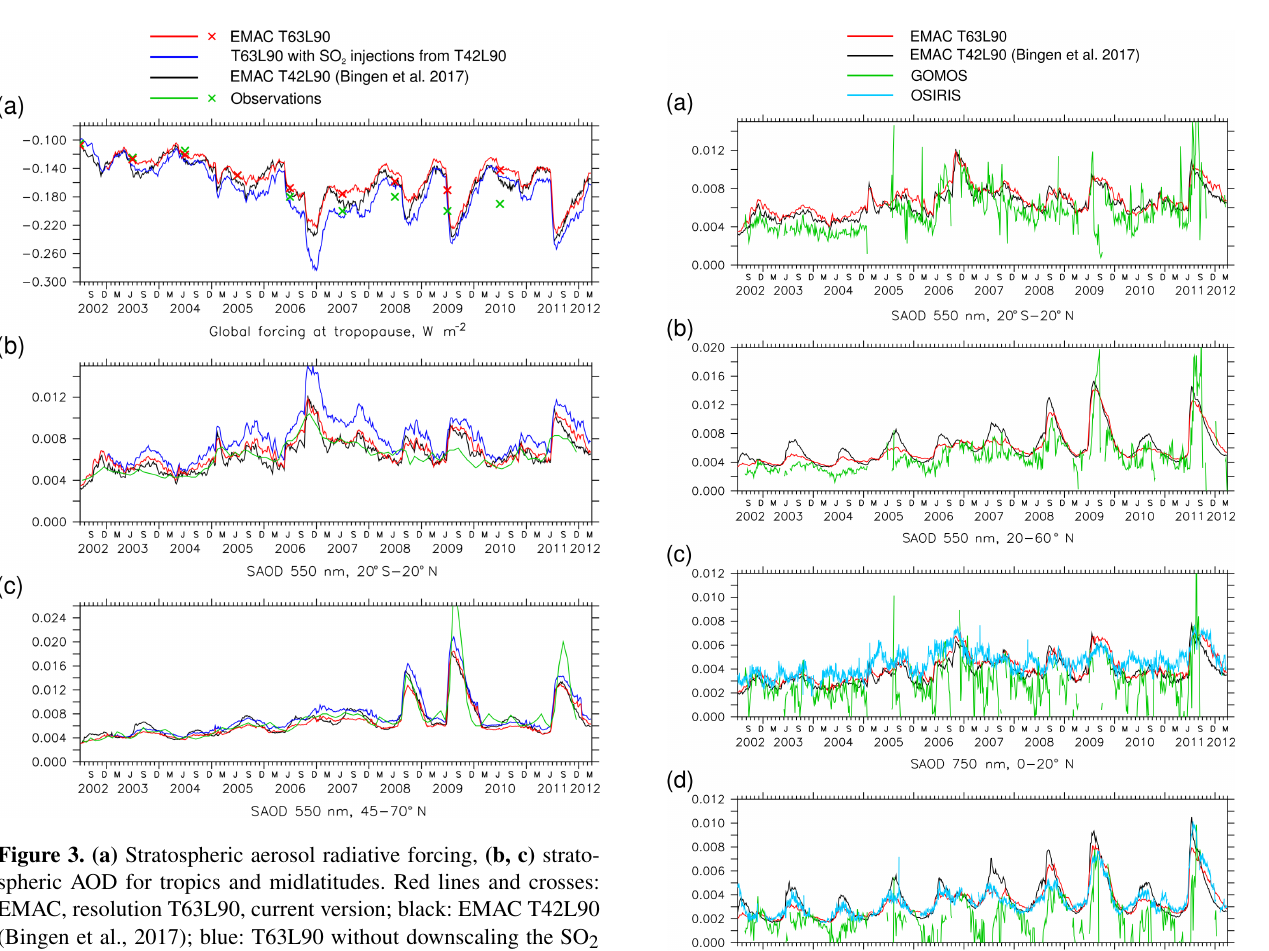
derived for the coarse resolution. Green lines and symbols show estimates derived from satellite observations (SAGE II, OSIRIS and CALIPSO; Solomon et al., 2011; Santer et al., 2014; Bourassa et al., 2012; Glantz et al., 2014). Red